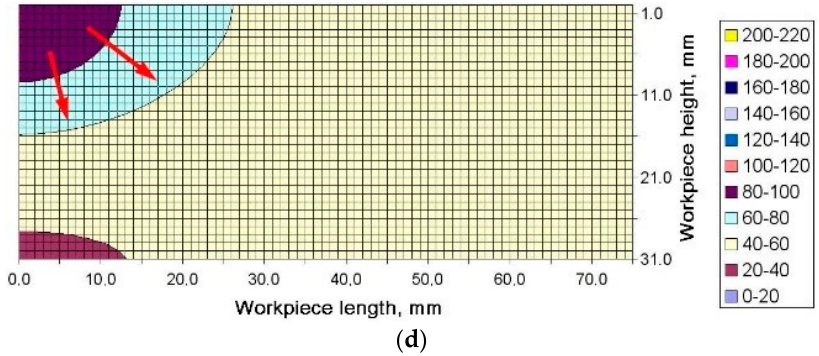
Figure 14. Temperature distribution for the first milling strategy in the cross-section along the workpiece length at ( a ) Δ t = 7.8 s, ( b ) Δ t = 8.8 s, ( c ) Δ t = 9.8 s, and ( d ) Δ t = 10.8 s.